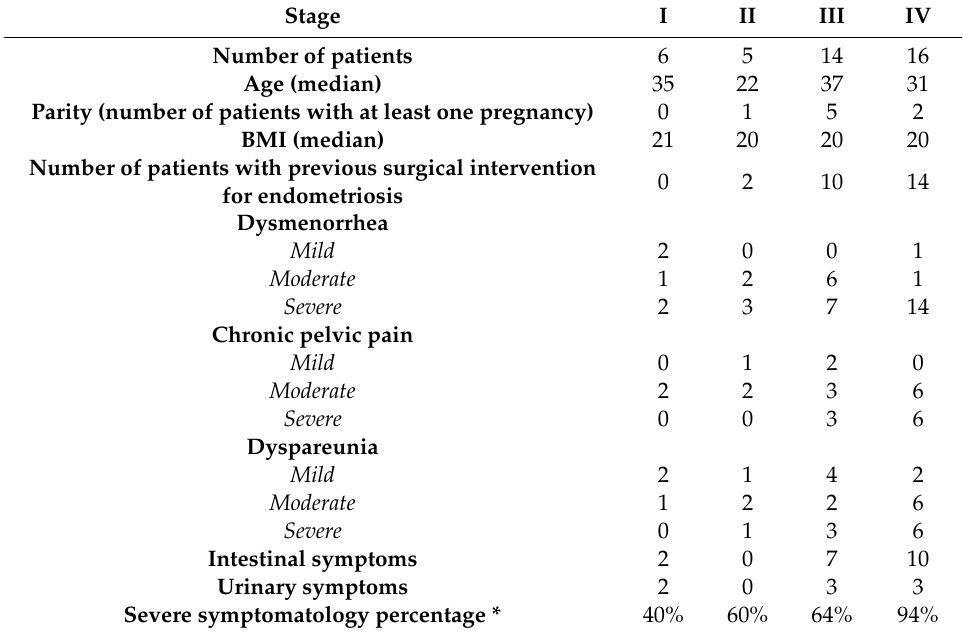
Table 2. Distribution of clinical anamnestic data of the group of a ff ected women. Stage